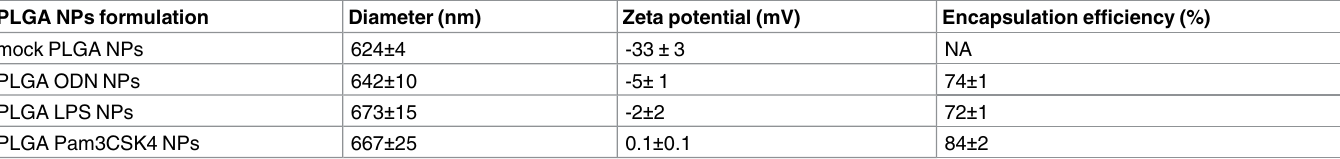
Table 2. Physical properties of PLGA NPs encapsulating different classesof TLR